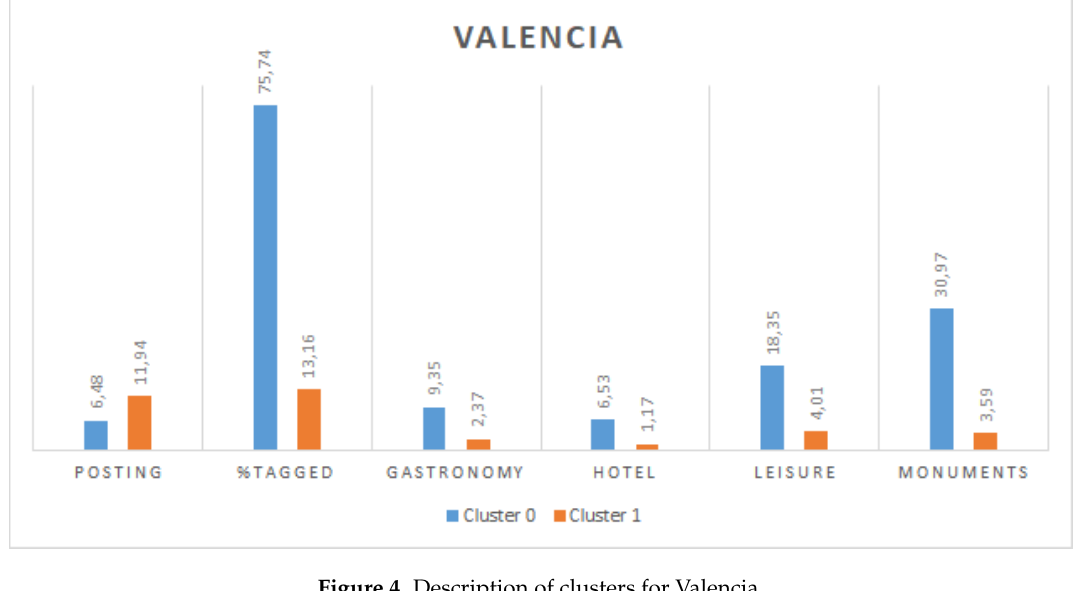
Figure 4. Description of clusters for Valencia.